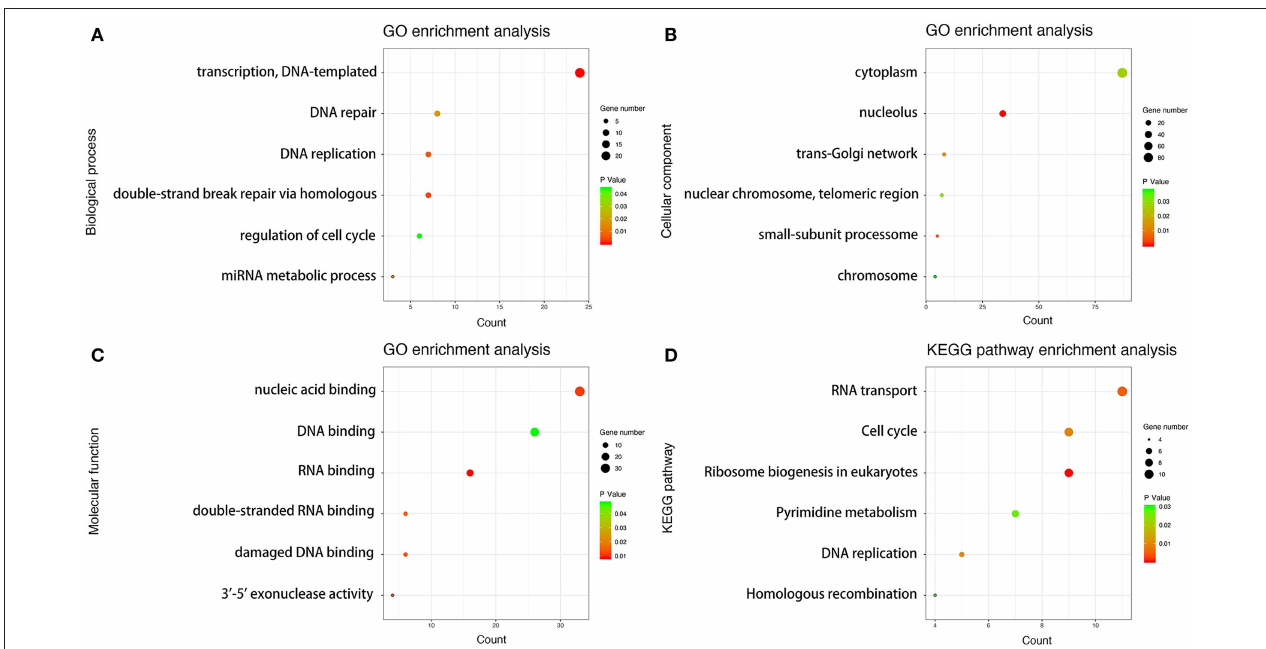
FIGURE 5 | GO and KEGG pathway enrichment analysis. (A) Biological process analysis. (B) Cellular component analysis. (C) Molecular function analysis. (D) KEGG pathway analysis.